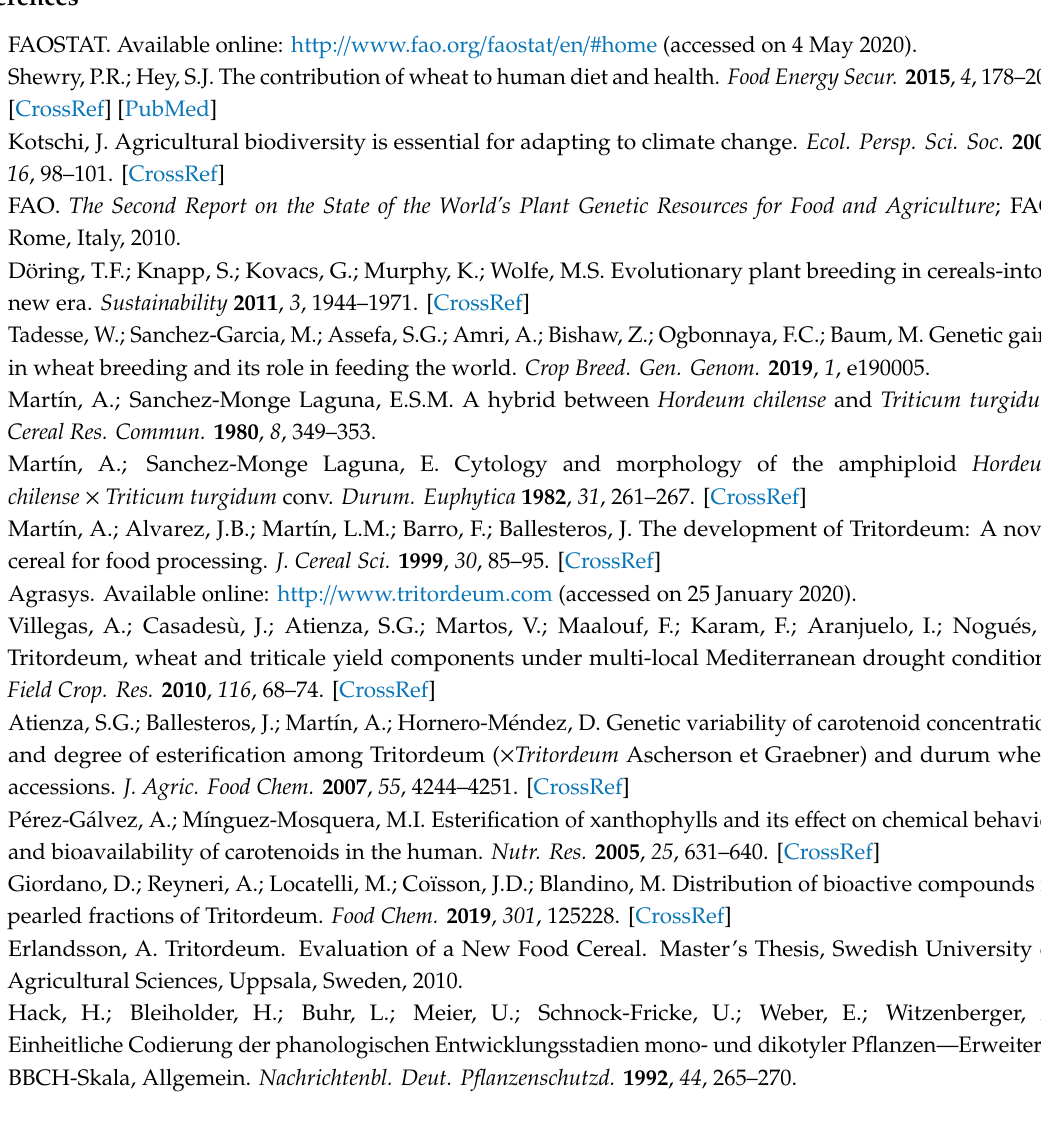
Figure S1: Rarefaction curves generated for 16S rRNA gene sequences obtained from samples. Panels represent the rarefaction curves of aggregates of the 16 samples of bulk soil (BS) and samples of the rhizosphere soil of durum wheat (cv. Iride, IR) and Tritordeum (cv. Bulel, cv. HTC-444) under organic (org) and conventional (conv) management. Table S1: Data filtering report of sample runs. Table S2: Bacterial phyla with relative variations (var) and significance levels ( p -value) in bulk soil and in the rhizosphere soil of durum wheat (cv. Iride) and Tritordeum (cv. HTC-444, cv. Bulel) cultivated under organic (org) and conventional (conv) agricultural management. Data are presented as percentage abundances of the mean values of 3 biological replicates. Table S3: Bacterial families with relative variations (var) and significance levels ( p -value) in bulk soil and in the rhizosphere soil of durum wheat (cv. Iride) and Tritordeum (cv. HTC-444, cv. Bulel) cultivated under organic (org) and conventional (conv) agricultural management. Data are presented as percentage abundances of the mean values of 3 biological